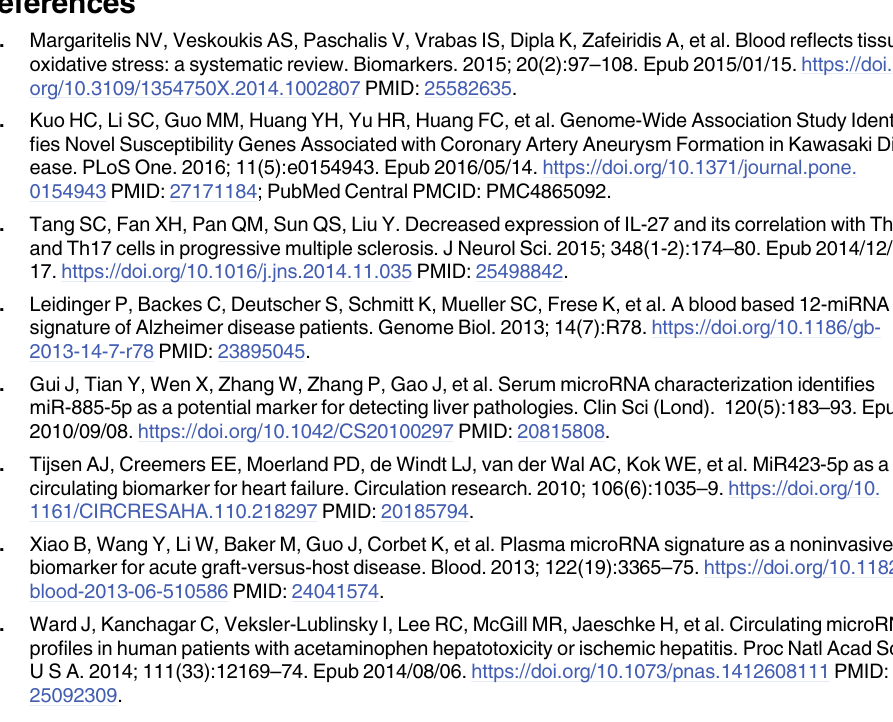
S1 Table. The raw data for plotting figures. The raw data for plotting each figure and sub– figure is available in S1 Table. These digits are RIN value, 260/280 value, qPCR Ct value, WBC count, WBC concentration or methylation percentage. Empty columns denote failed experi-